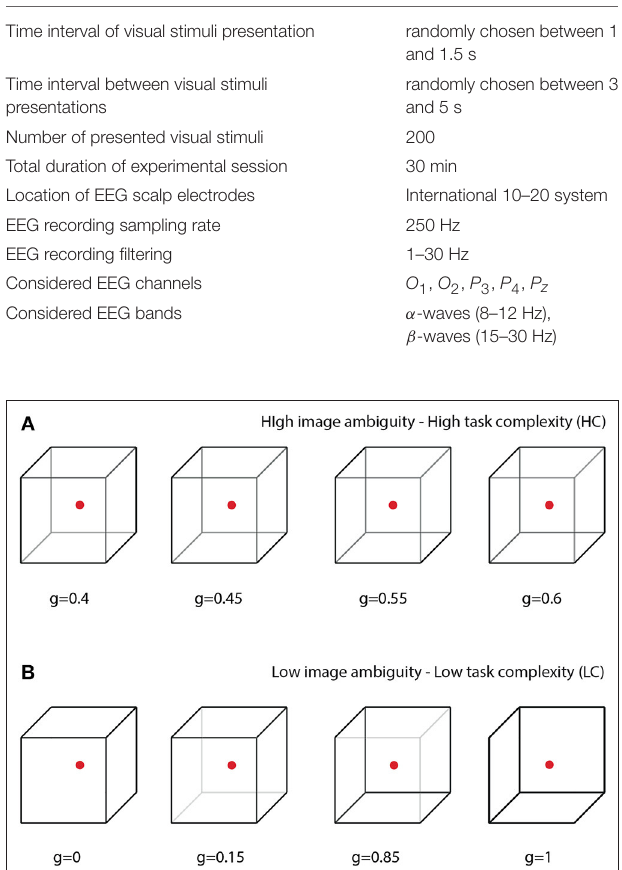
FIGURE 1 | Complete set of visual stimuli split into two sets: (A) cubes with high degree of ambiguity representing tasks of high complexity (HC) and (B) cubes with low degree of ambiguity representing tasks of low complexity